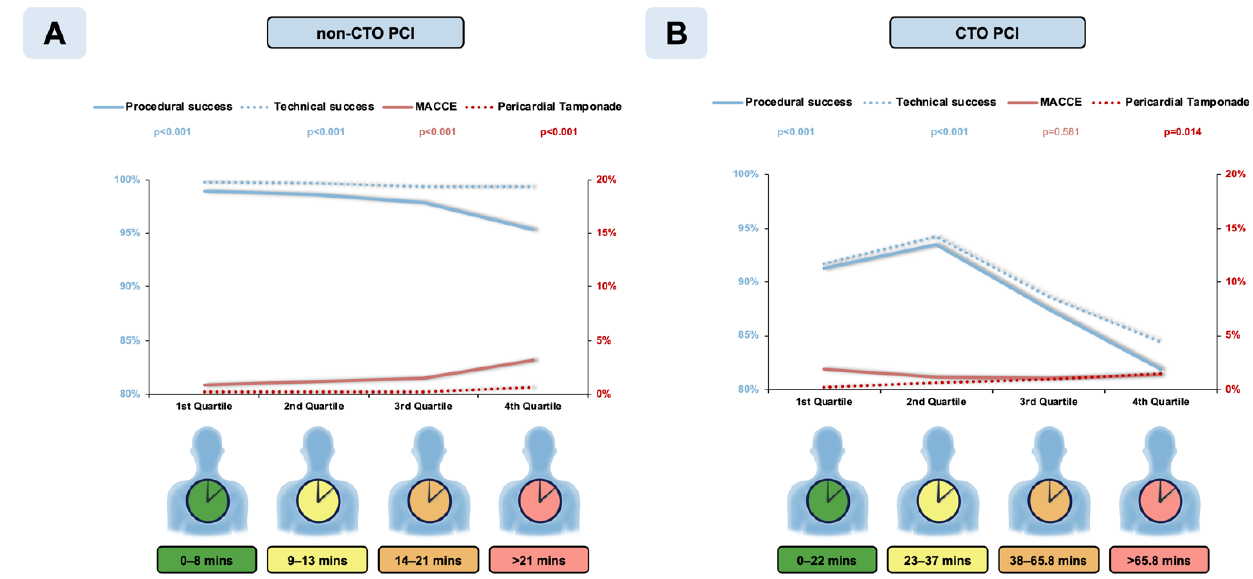
7 of 12 Figure 2. Forest plot of crude (Panel A) and adjusted (Panel B) odds ratios (OR) for prediction of procedural success in nonocclusive percutaneous coronary intervention (non-CTO PCI). ACC, American College of Cardiology; AHA, Ameri- can Heart Association; CABG, coronary artery bypass graft; eGFR, estimated glomerular filtration rate; LVEF, left ventric- ular ejection fraction; MI, myocardial infarction; NYHA, New York Heart Association. * Indicates fluoroscopy time (min). Left ventricular function groups are indicated as follows: normal (52–100%) moderately reduced (41–51%), reduced (30–